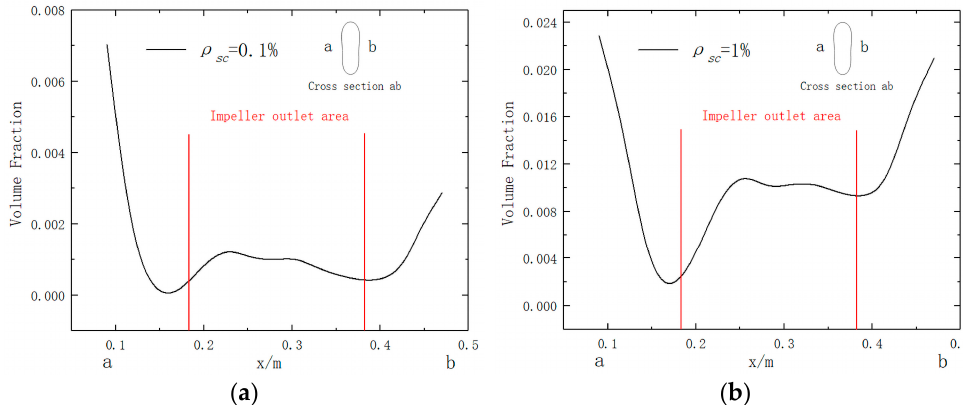
Figure 6. Cross-section ab solid particle volume fraction variation trend diagram: ( a ) sediment concentration ρ sc = 0.1%; ( b ) sediment concentration ρ sc = 1%.